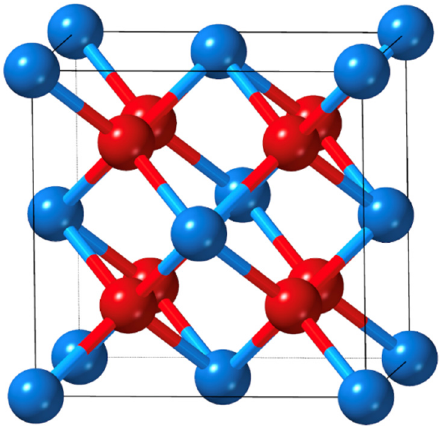
Figure 1. Unit cell of fluorite AnO 2 . The blue and red atoms correspond to the actinide and oxygen atoms, respectively.